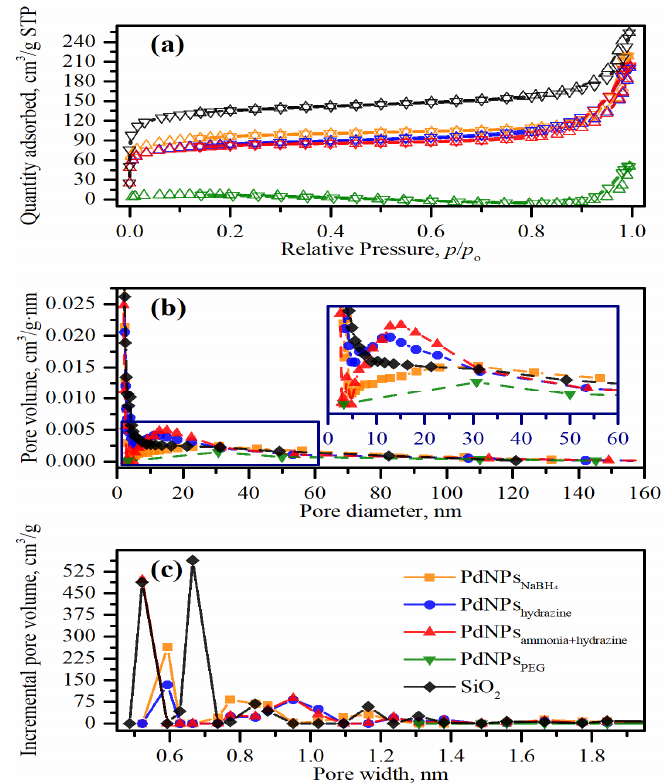
Figure 4. ( a ) N 2 sorption isotherms for the samples: Pd-NPs NaBH ₄ (orange), Pd-NPs hydrazine (blue), Pd-NPs ammonia,hydrazine (red), Pd-NPs PEG (green), and SiO 2 support (black). Absorption and desorption directions are marked by up- and down-triangles, respectively. Corresponding Barrett–Joyner–Halenda (BJH) and density functional theory (DFT) pore size distributions are shown in parts ( b ) and ( c ), respectively.